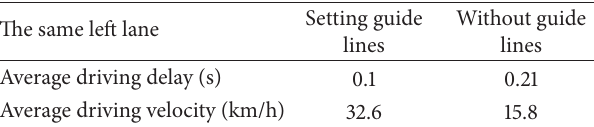
Table 1: The calculation results.